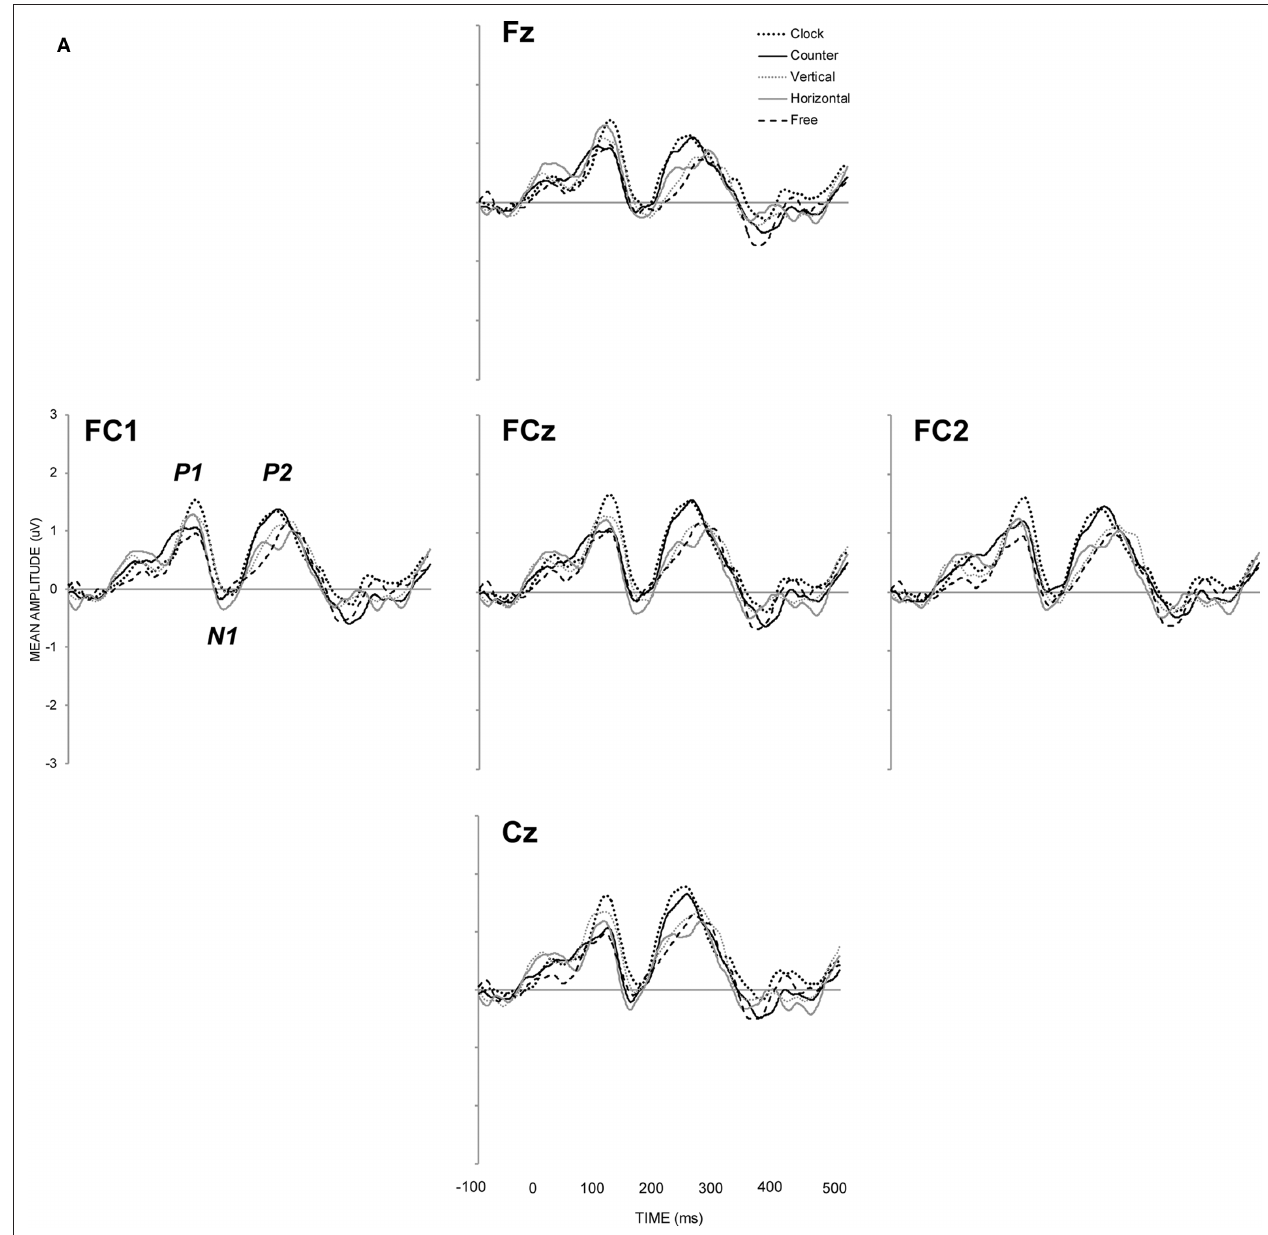
Figure 3 | group mean event-related brain potentials for (A) auditory stimuli calculated as the difference wave between sound and silence conditions,